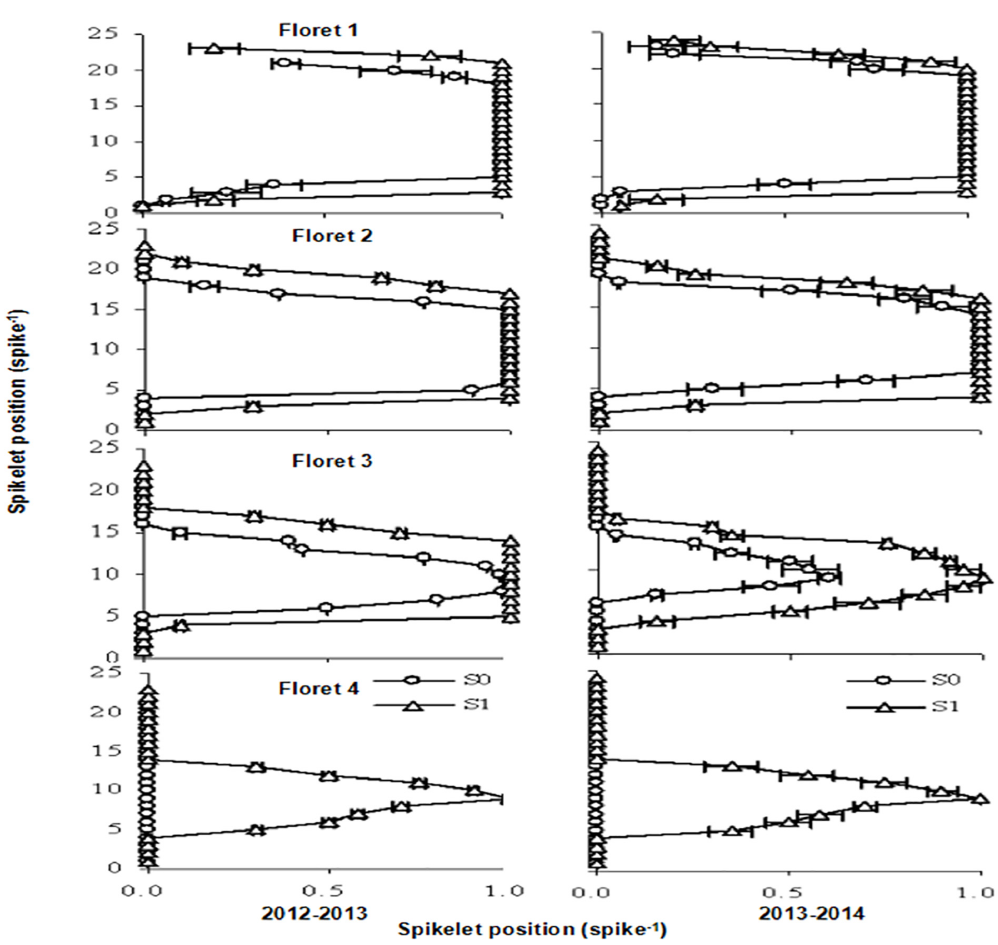
Fig 5. Effect of foliar spray treatment (S0: water [circles]; S1: 6-BA [triangles]) on likelihood of grain set in different floret positions (from F1 to F4) for different spikelet positions throughout the spike.